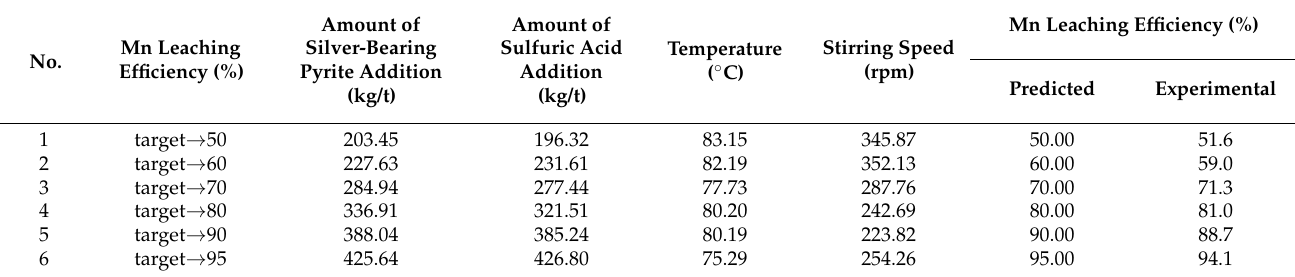
Table 7. Potential optimization conditions based on CCD for Mn leaching